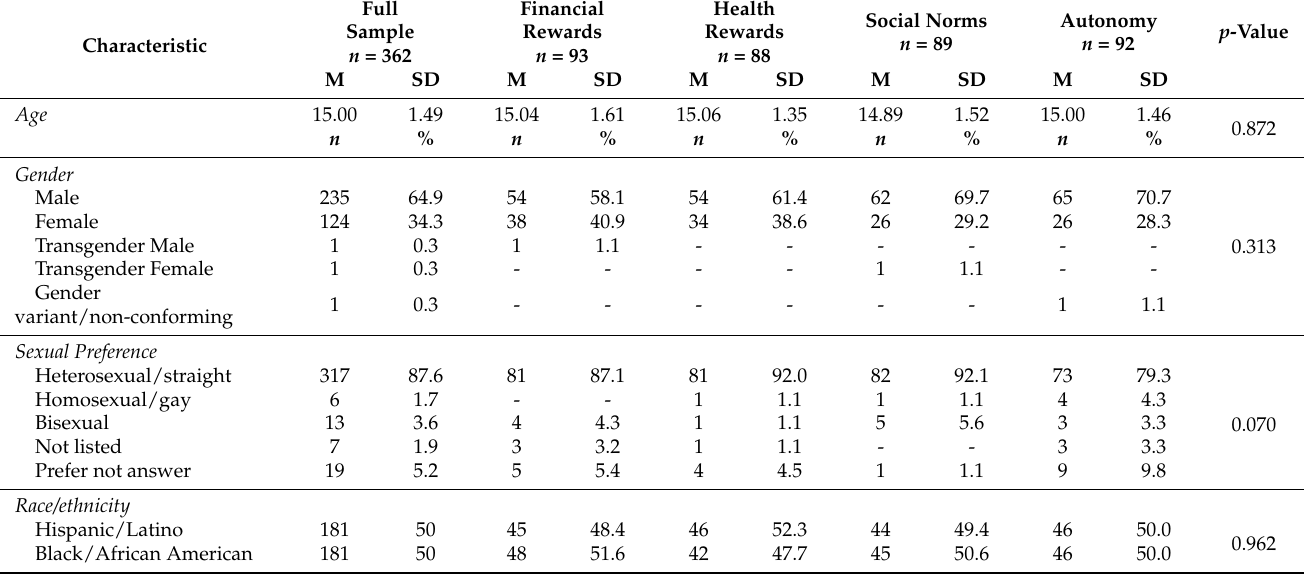
Table 1. Sociodemographic characteristics of participants.